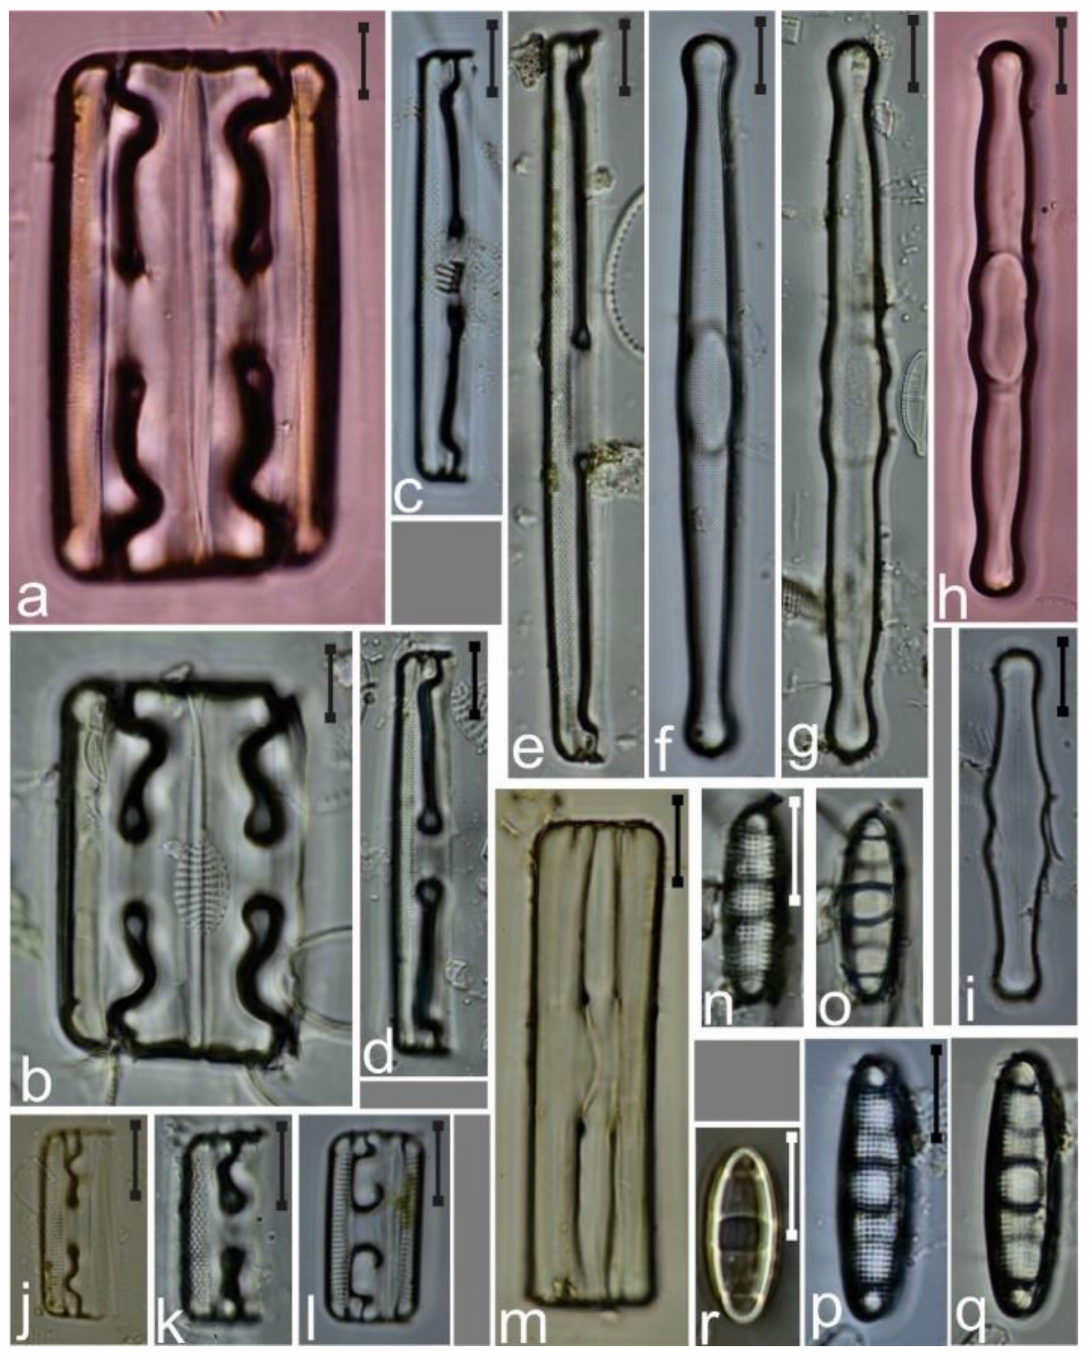
Figure 21. ( a , b ) Grammatophora macilenta ; ( c – f , j ) G. oceanica ; ( k ) G. marina ; ( g – i , m ) G. undulata var. gallopagensis ; ( l , n – r ) G. hamulifera . Scale bar = 10 µ